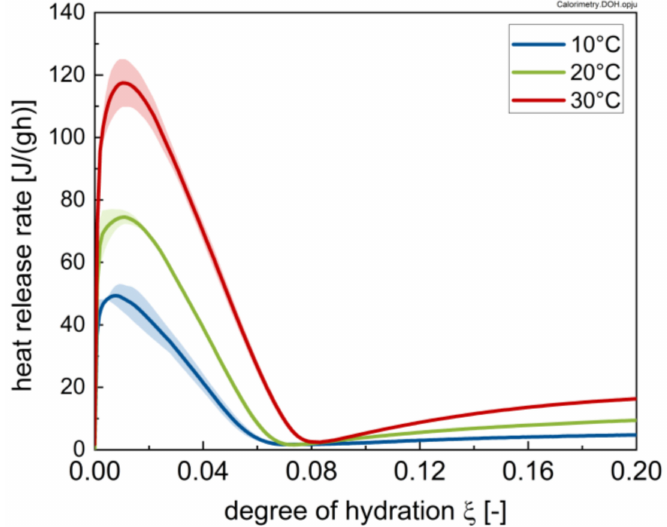
Figure 17. Heat flow of the investigated cement paste for di ff erent temperatures (10, 20 and 30 ◦ C) as a function of the degree of